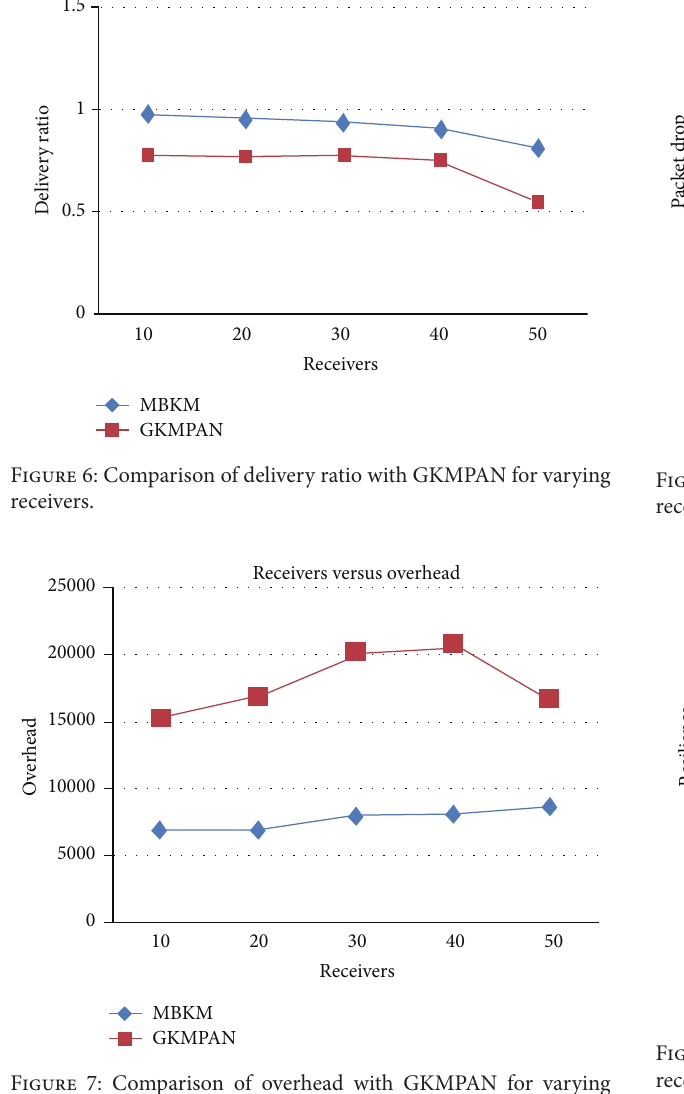
Figure 7: Comparison of overhead with GKMPAN for varying receivers.